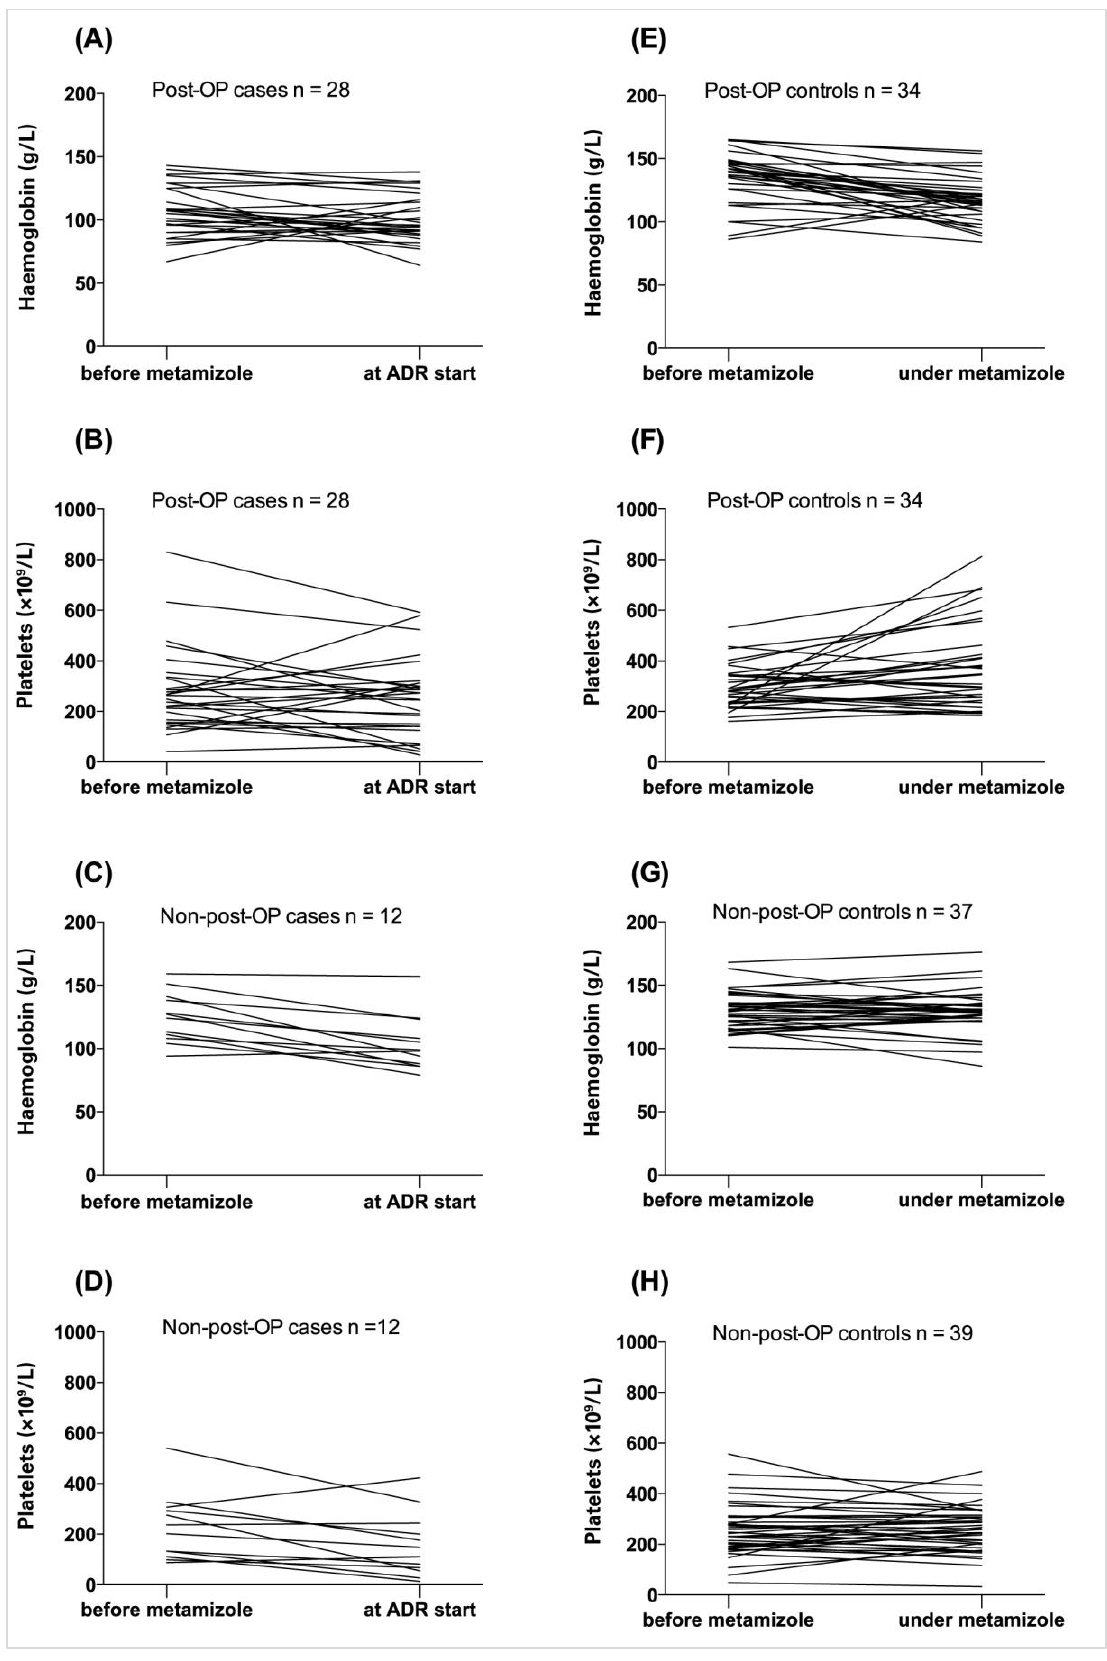
Figure 2: Haemoglobin and platelet counts before starting metamizole and at time of diagnosis of ADR (case group A–D) or at last follow-up while taking metamizole (control group EH). ADR adverse drug reaction; post-OP =